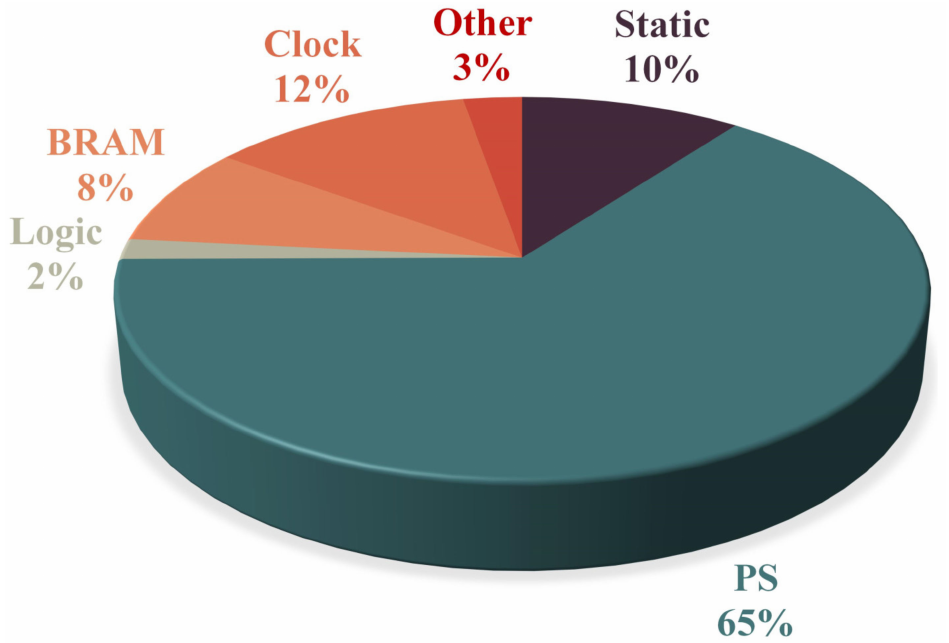
Figure 9. Power consumption